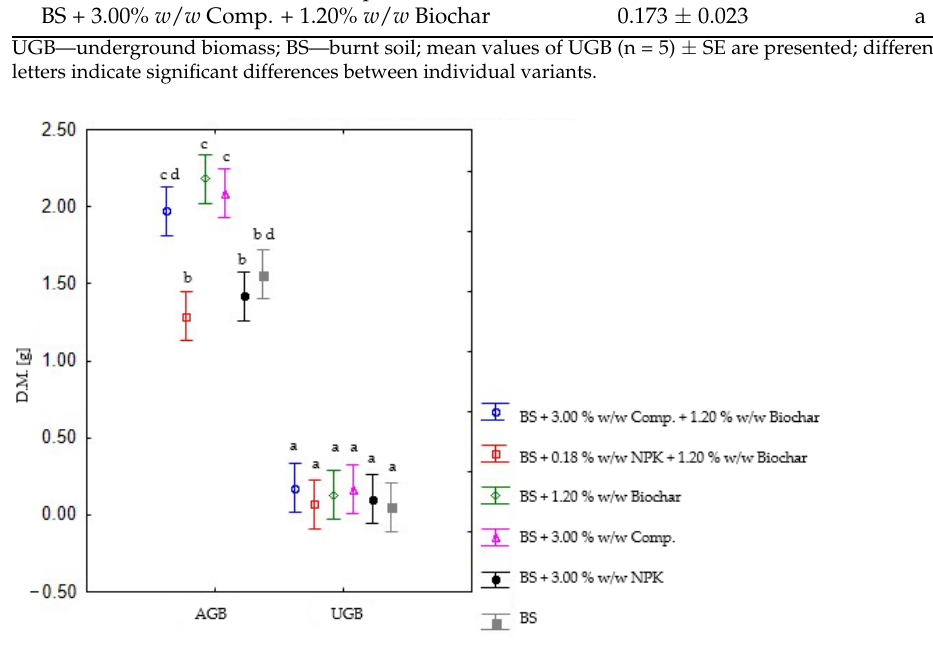
Figure 4. Graphical illustration of the effect of individual factors (soil amendments and type of biomass) on the D.M. biomass yield. Vertical columns present mean values of AGB and UGB ± SE (n = 5). Different small letters indicate significant differences between individual variants.